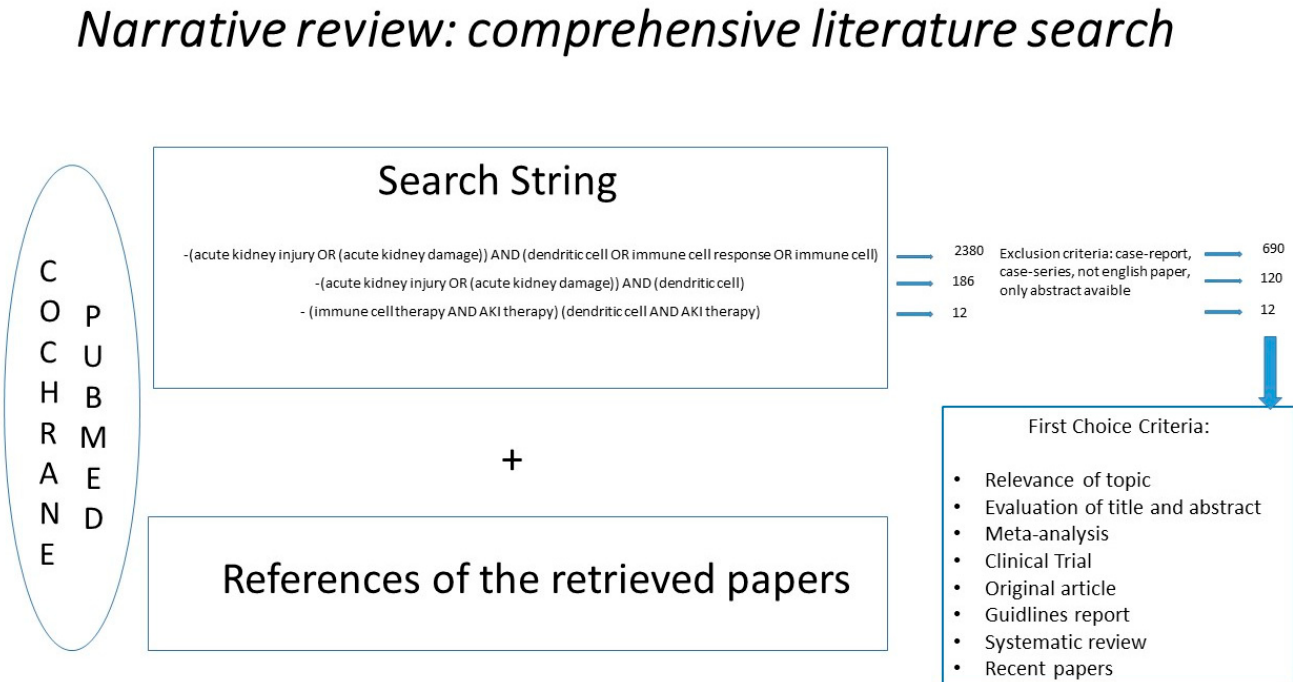
Figure 1. Graphical summary of search criteria in the literature.